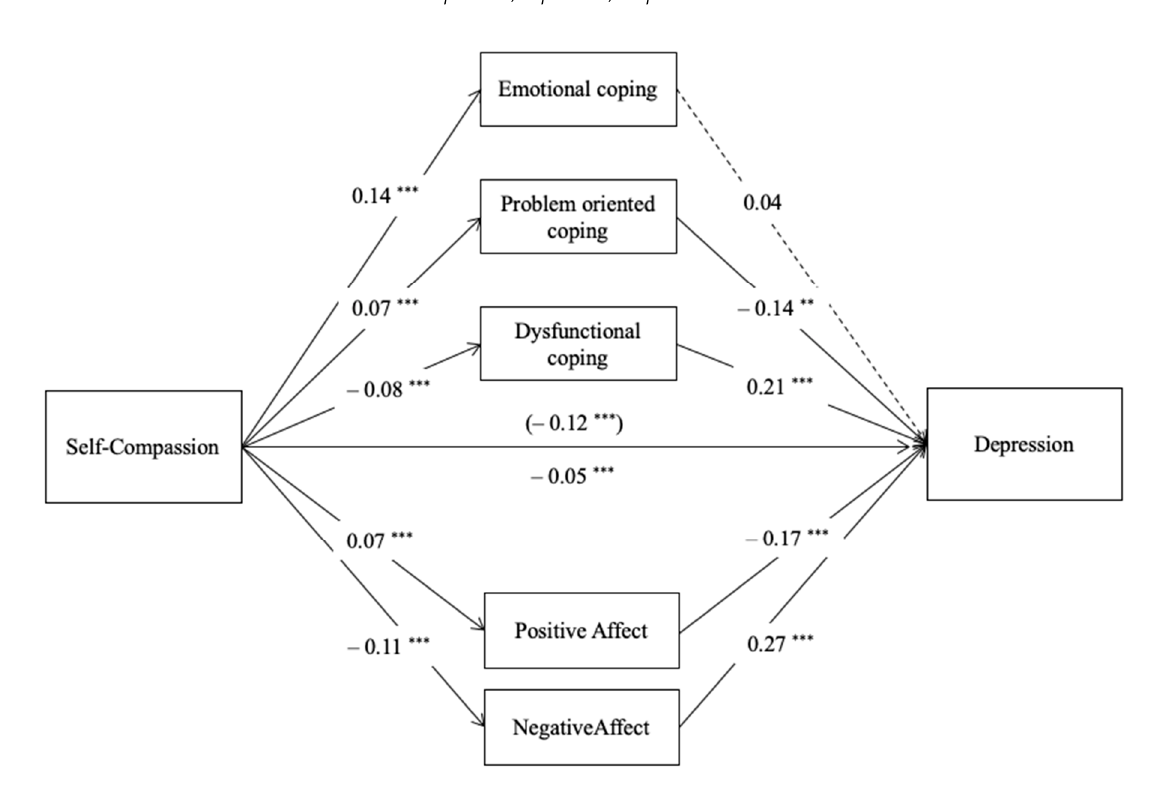
Figure 1. Parallel mediation model with path coefficients (unstandardized): self-compassion, positive affect, negative affect, emotional coping, problem-oriented coping, dysfunctional coping, and symptoms of depression (M1). Note: ** p < 0.01 *** p < 0.001, c’ (direct effect) above the line and c (total effect) below the line, dashed lines are not-significant paths.